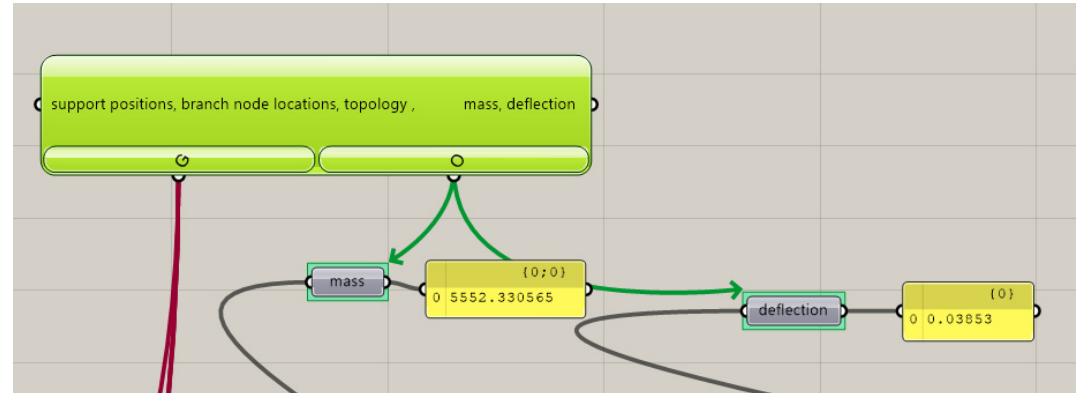
Figure A2. Result of the first simulation for a structure with pattern a.